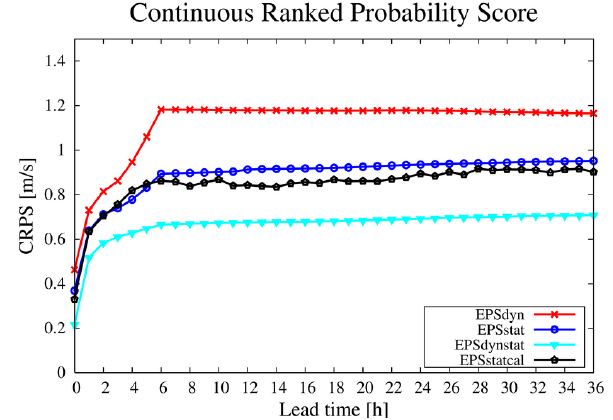
Figure 7. CRPS as a function of lead time, from the dynamical (red), statistical (dark blue) and dynamic-statistical (light blue) method. Furthermore, a calibrated-statistical approach indicating the skill of a further calibration of the statistical method is added (black).